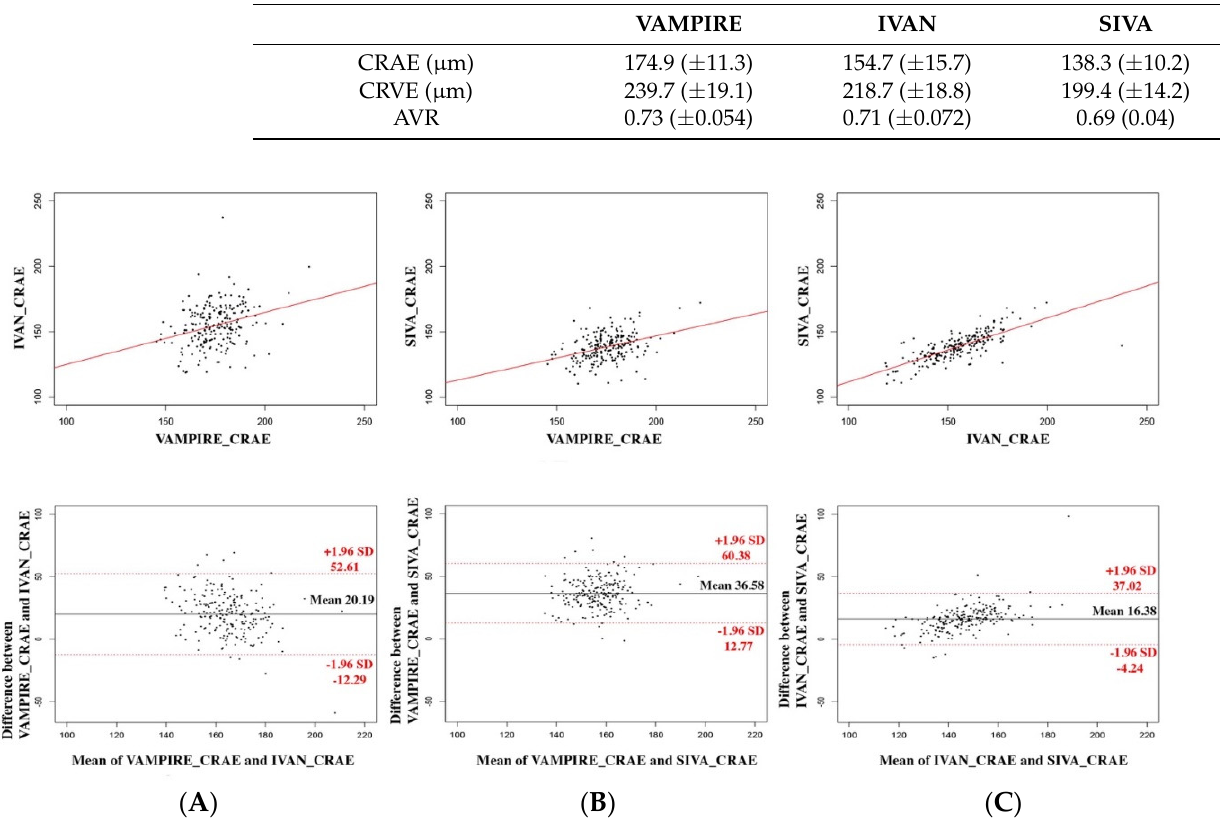
Figure 2. Agreement between each software for CRAE measurements. The three software applications are compared two by two: ( A ) IVAN and VAMPIRE, ( B ) SIVA and VAMPIRE, ( C ) SIVA and IVAN. Scatterplots are represented above with regression lines; Bland–Altman plots are represented below.